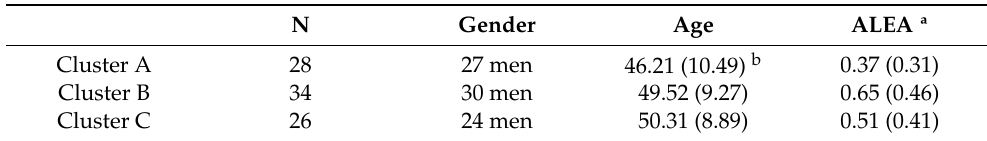
Figure 1. Dendrogram for a hierarchical cluster analysis on farmers’ questionnaire scores. Table 1. Descriptive statistics by cluster.